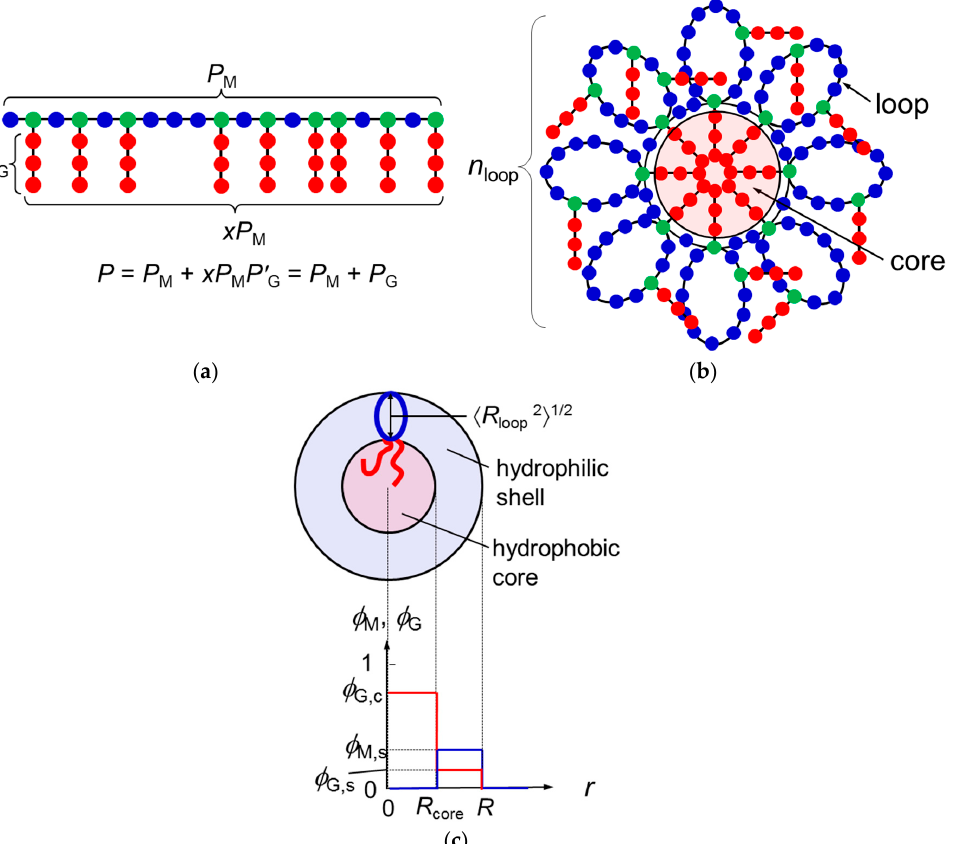
Figure 1. Schematic diagrams of the graft copolymer chain ( a ), the flower micelle formed by the copolymer chain ( b ), and the radial concentration profiles of the main-chain and graft-chain units in the flower micelle ( c ). In Panel b, the flower micelle is constructed by m copolymer chains. In Panel a, blue and green circles are referred to as the main chain, and red circles as the graft chain. In Panels a and b, blue circles are called the A unit, and red and green circles as the B unit to discuss the mixing enthalpy (cf. Equations (9)–(11)).